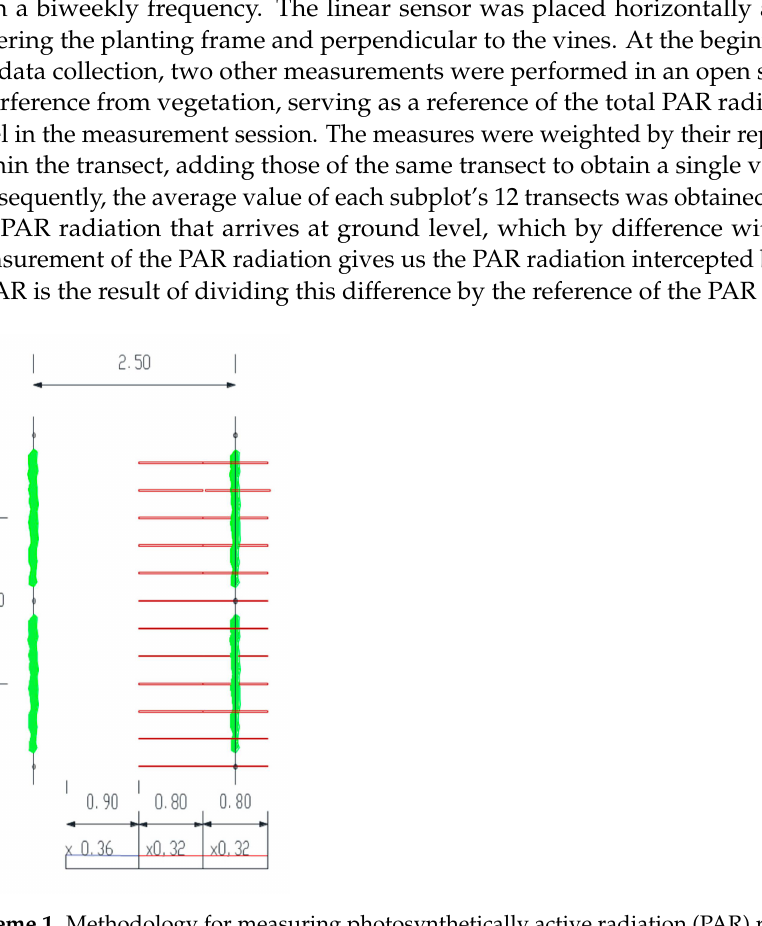
Scheme 1. Methodology for measuring photosynthetically active radiation (PAR) radiation, with the dimensions in meters and the weighting values of each